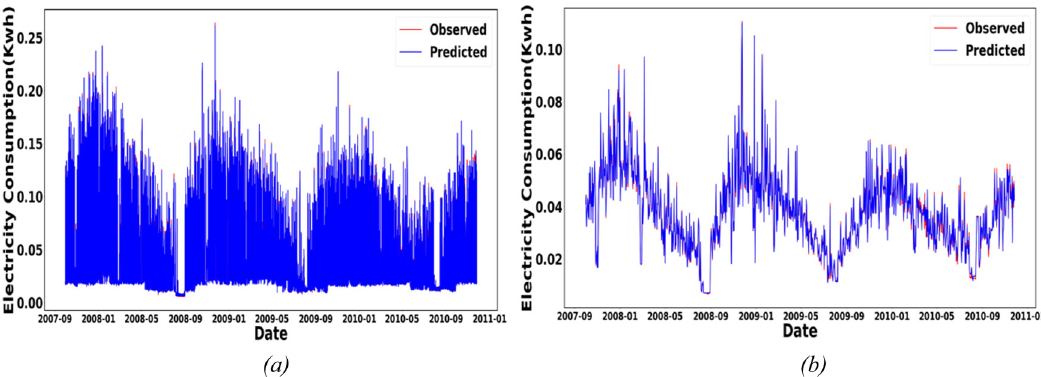
Figure 13: Household predictions vs original observations after feature normalization: ( a ) hourly granularity and ( b ) daily granularity.